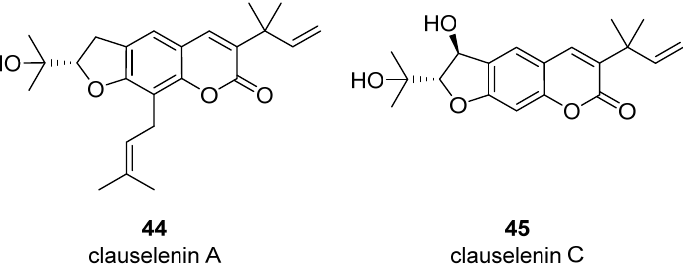
Figure 7. Structure of clauselenins A and C 44 and 45 .